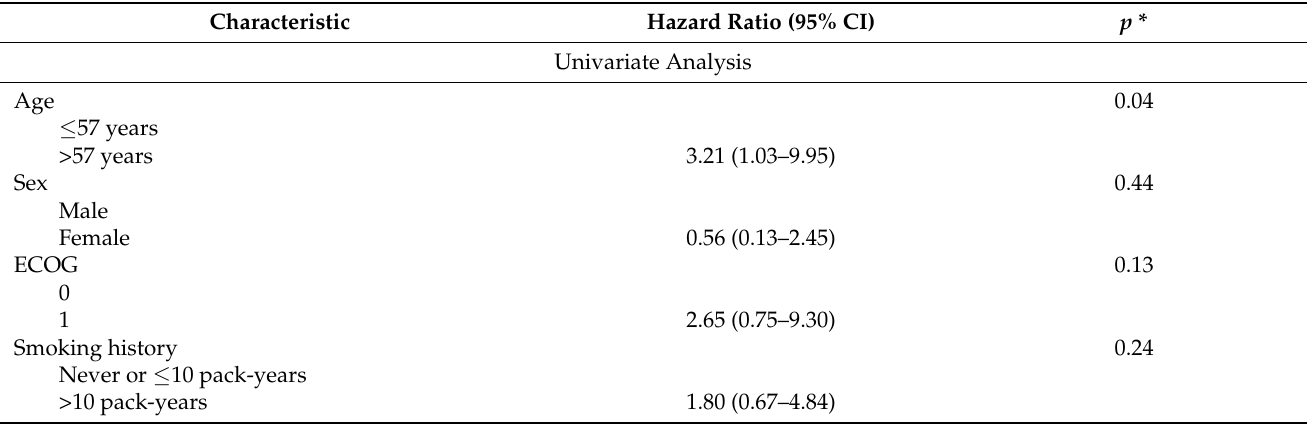
Table 2. Univariate and multivariate analyses for progression-free